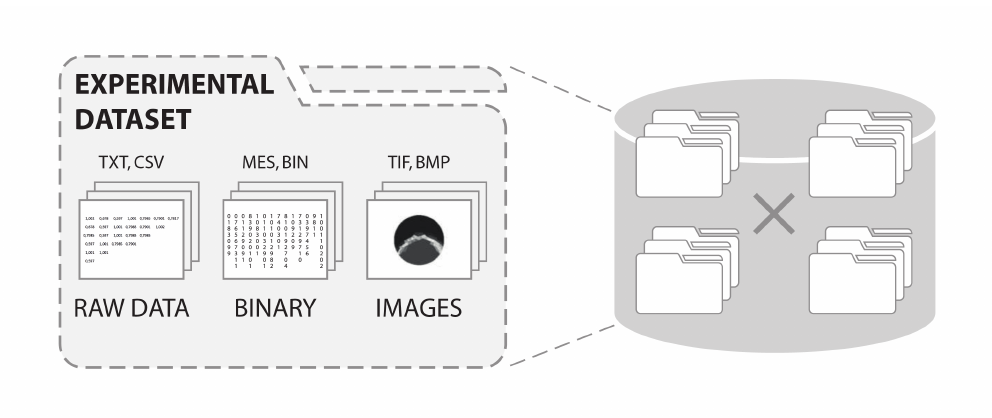
Figure 2. Process tomography measurement data: illustration of a typical experimental data set consisting of a variety of data types and formats ( left ) aggregated into a larger data collection repository ( right